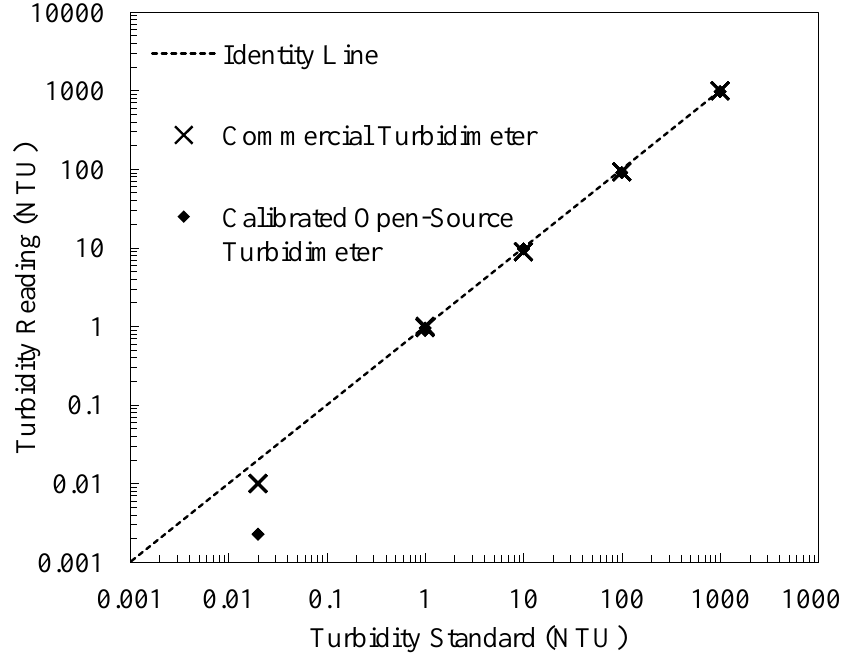
Figure 5. Commercial and open-source turbidimeter measurements of five non-formazin turbidity standards.